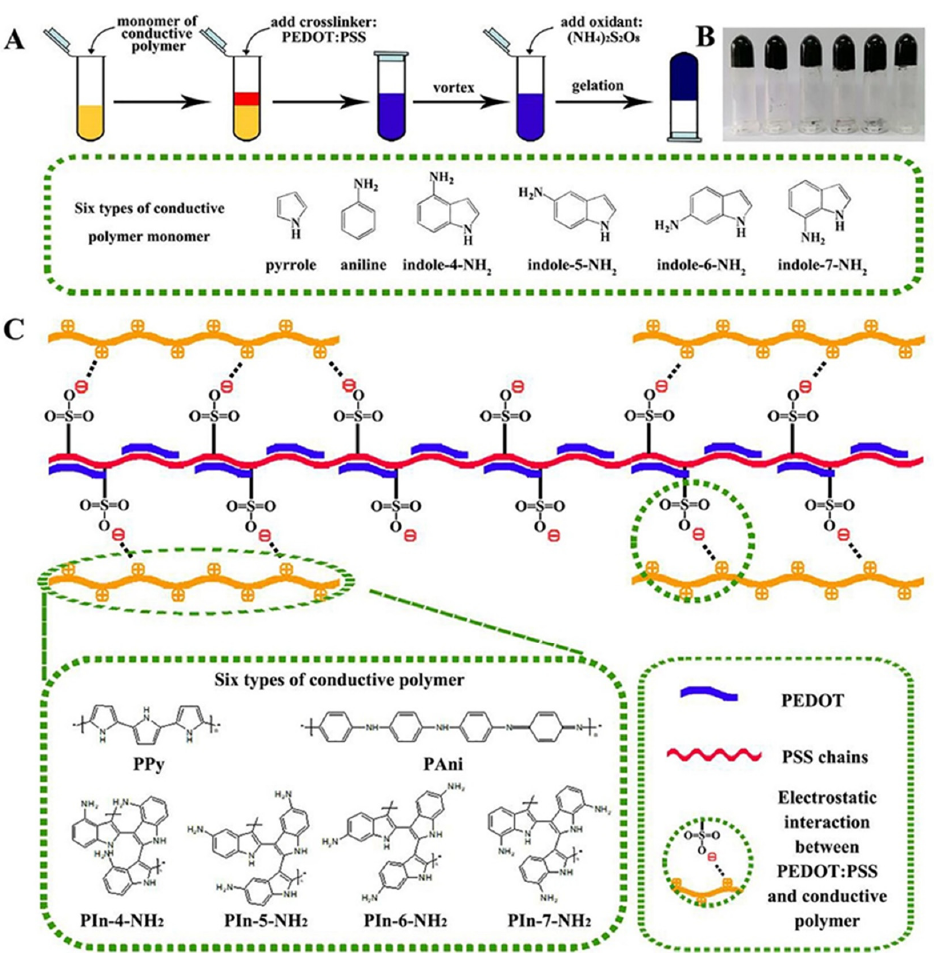
Figure 19. ( A ) Schematic illustration of gelation processes for six types of conductive polymer hydrogels: PPy, PAni, PIn-4-NH2, PIn-5-NH2, PIn-6-NH2, and PIn-7-NH2. ( B ) Photographs of the conductive polymer hydrogels (from left to right: PPy/PEDOT:PSS hydrogel, PAni/PEDOT:PSS hydrogel, PIn-4-NH2/PEDOT:PSS hydrogel, PIn-5-NH2/PEDOT:PSS hydrogel, PIn-6-NH2/PEDOT:PSS hydrogel, PIn-7-NH2/PEDOT:PSS hydrogel). ( C ) Crosslinking mechanism of the conductive polymer/PEDOT:PSS hydrogels. The addition of the PEDOT:PSS as the dopant and gelator possess a large amount of negatively charged sulfonic acid functional group, which can form electrostatic interaction with the positively charged conductive polymer chains. Reprinted/adapted with permission from Ref. [70]. 2020, Elsevier.